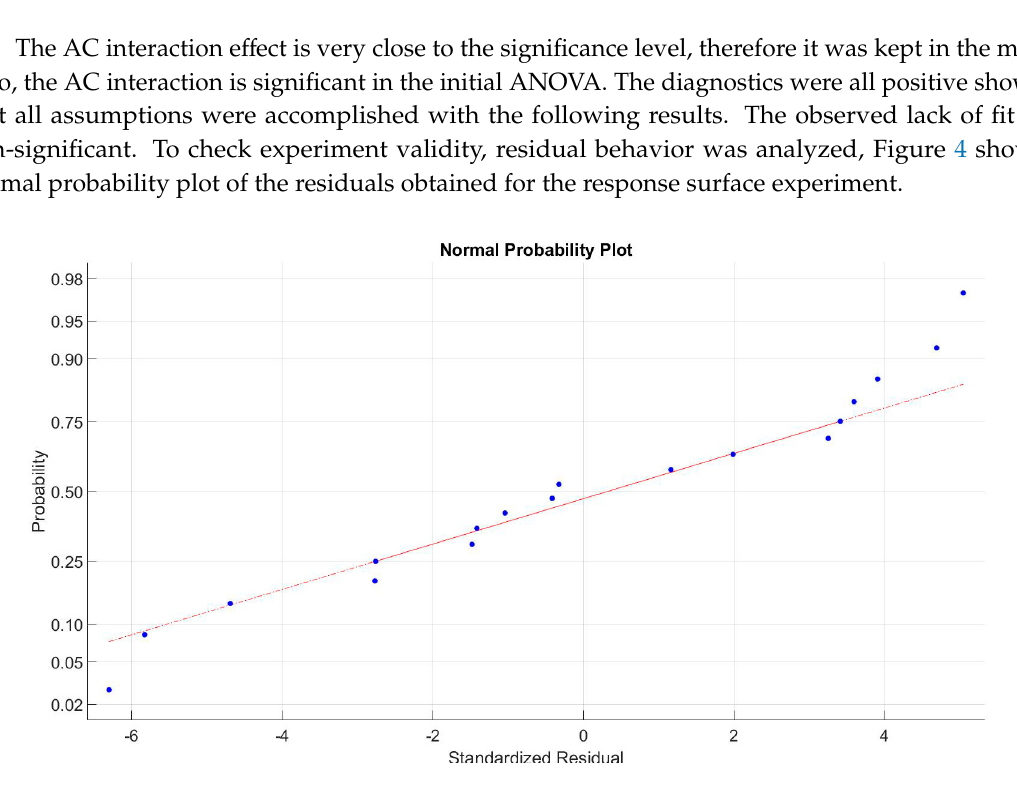
Figure 4. Normal probability plot of obtained residuals.